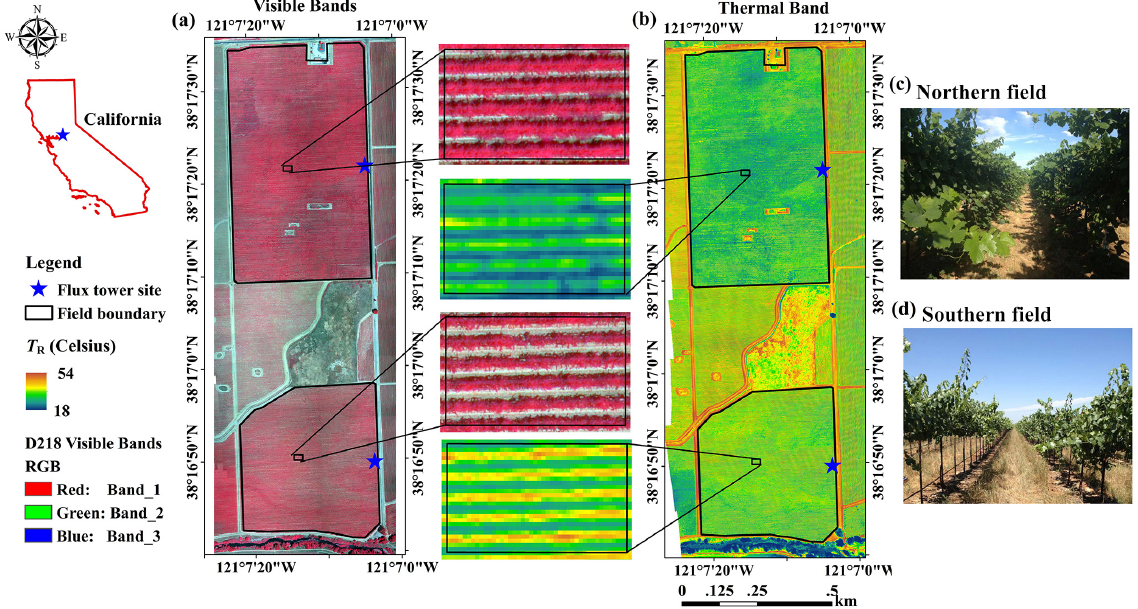
Figure 1. Location of study area overlaid on a false color composite of near-infrared (NIR), red, and green bands with 0.1m spatial resolu- tion (a) and thermal band with 0.66m spatial resolution (b) obtained by aircraft on 6 August, DOY 218, 2013. In the visible band image (a) , red and gray colors denote the vine and bare soil/senescent cover crop in the inter-row, respectively, while in the thermal band image (b) , blue/green and yellow/red colors represent vine and bare soil/senescent cover crop in the inter-row, respectively. The black line denotes the boundary of the northern and southern fields, and the blue stars are the locations of the flux tower sites. The two photos of the northern and southern fields (c, d) were taken on 11 June in 2014 after vines had fully leafed